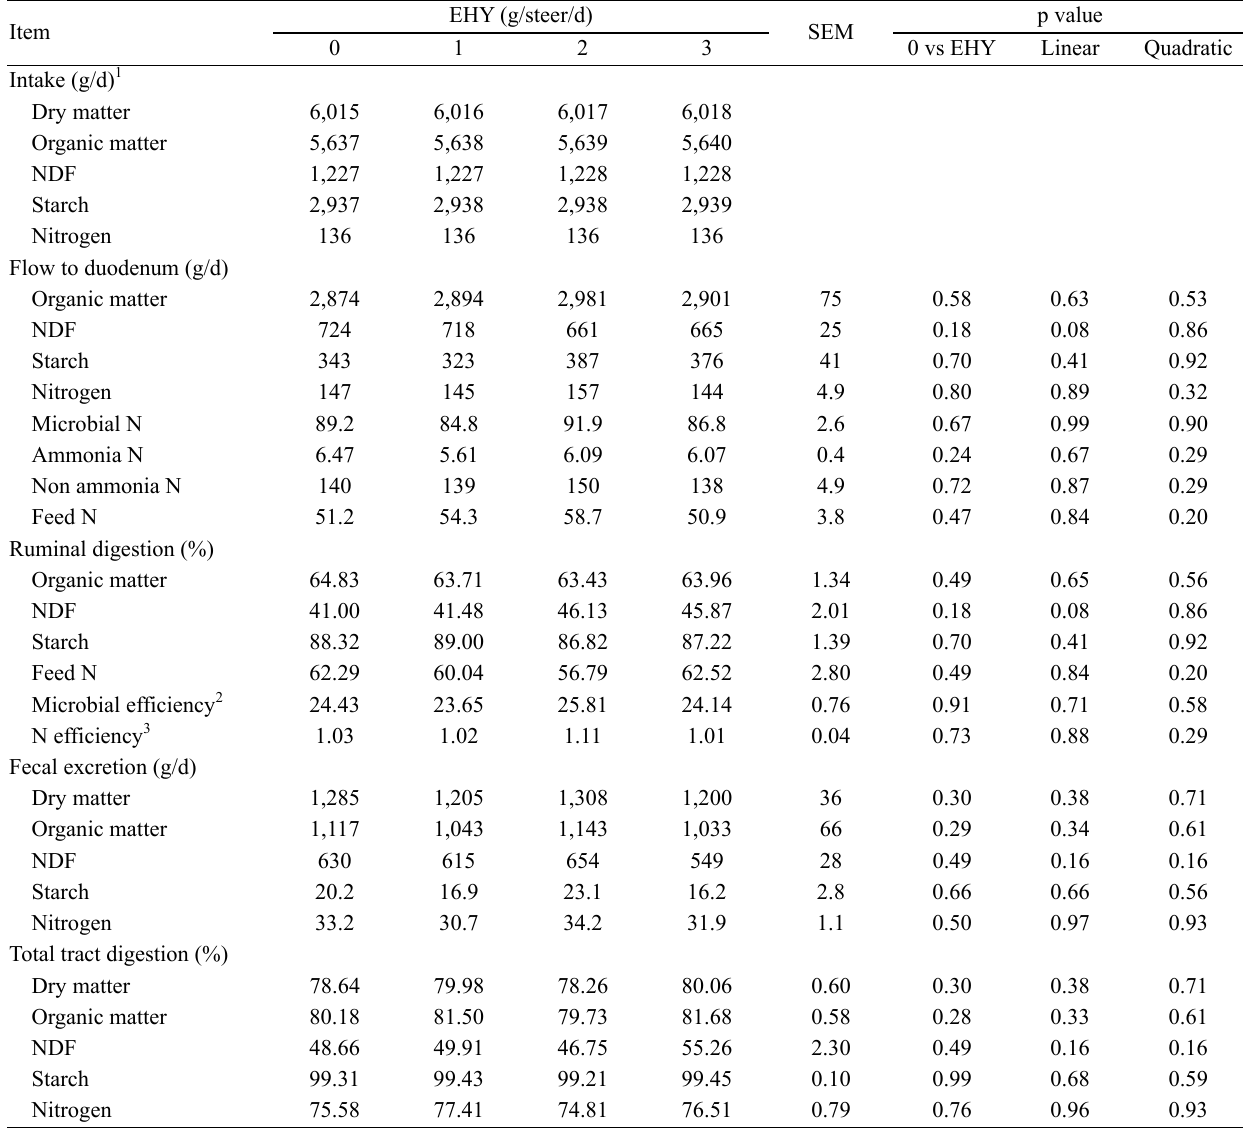
Table 4. Influence of enzymatically hydrolyzed yeast (EHY) supplementation on characteristics of ruminal and total tract digestion